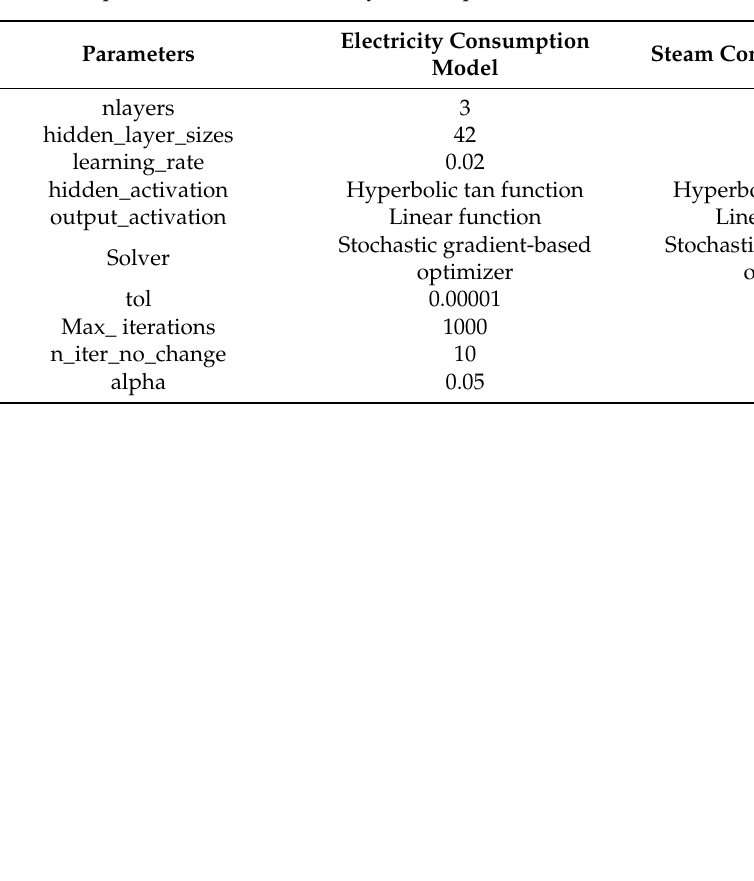
Table 4. The parameters of the electricity consumption model and the steam consumption